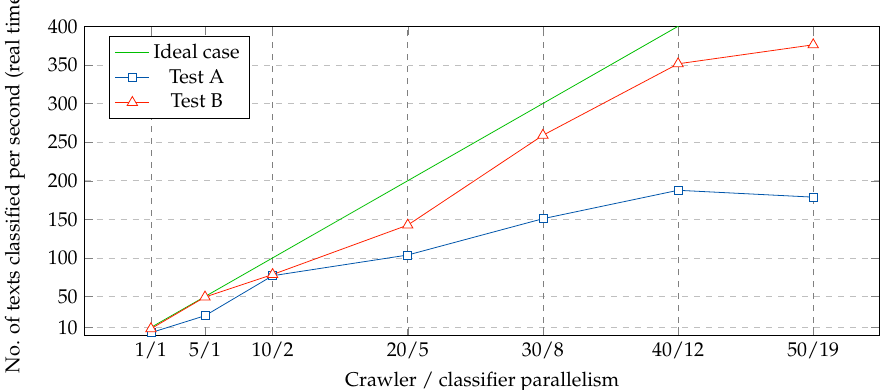
Figure 10. Parallelism level required to achieve real-time processing in one node.